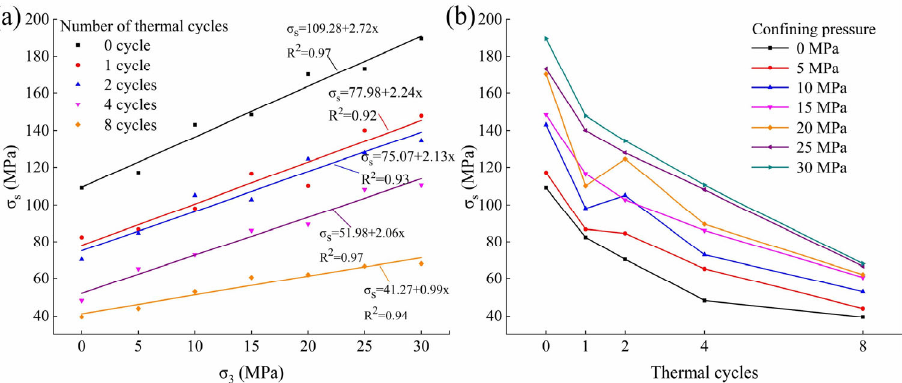
Figure 6. Relationship between the triaxial compressive strength of marble and confining pressure and number of thermal cycles. ( a ) σ s (Peak stress) ‐σ 3 under different thermal cycles; ( b ) σ s ‐ thermal cycles under different confining pressure.